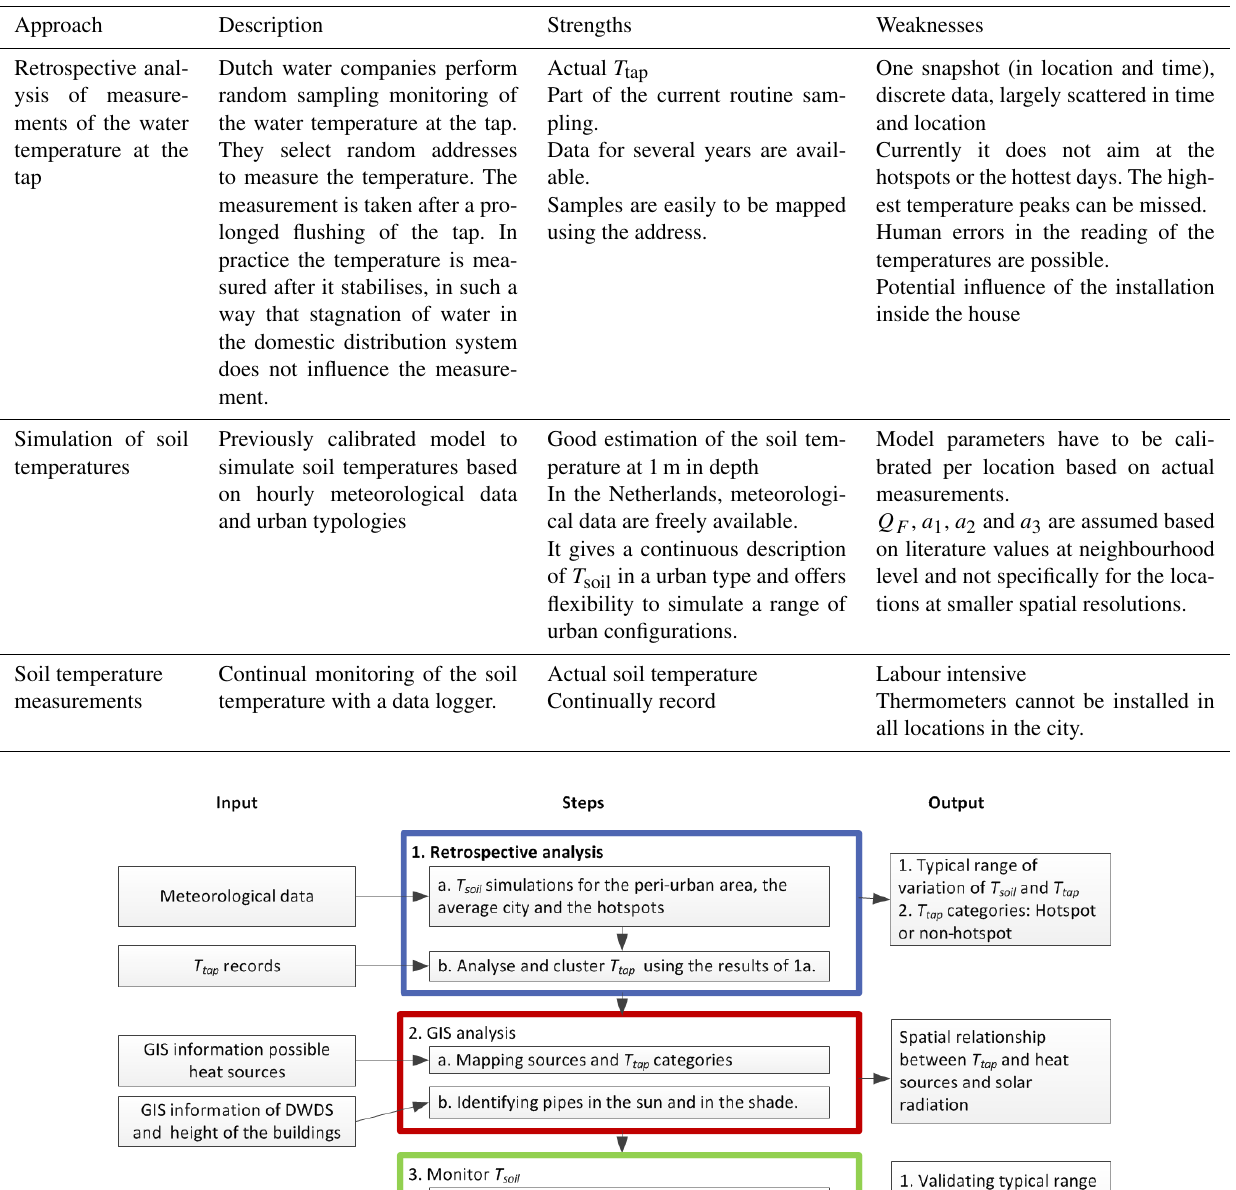
Table 1. Methods to determine soil or water temperature.